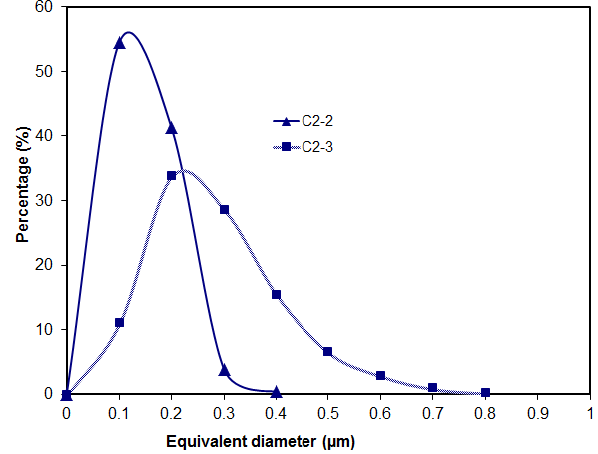
Figure 2. Back scatter electron SEM images of dispersoids after homogenization: ( a ) C2 ‐ 2; and ( b ) C2 ‐ 3.